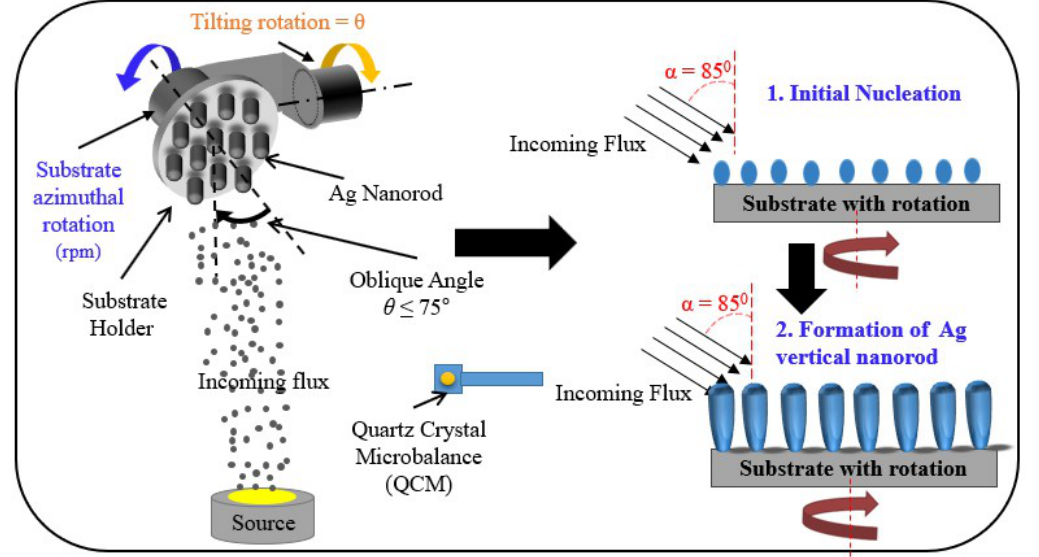
Figure 1. Schematic of the glancing angle deposition (GLAD) system with vertical Ag nanorod formation.